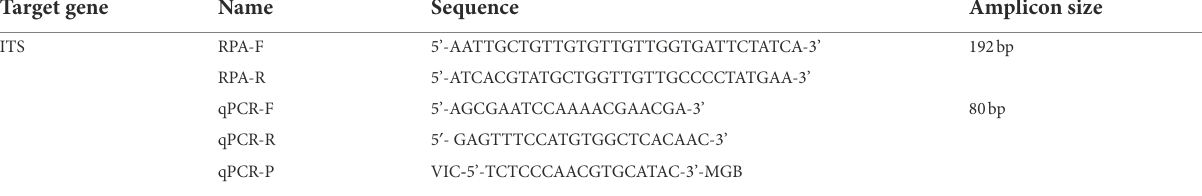
TABLE 1 Primers and probe used in RPA assay and qPCR for anisakid detection. Target